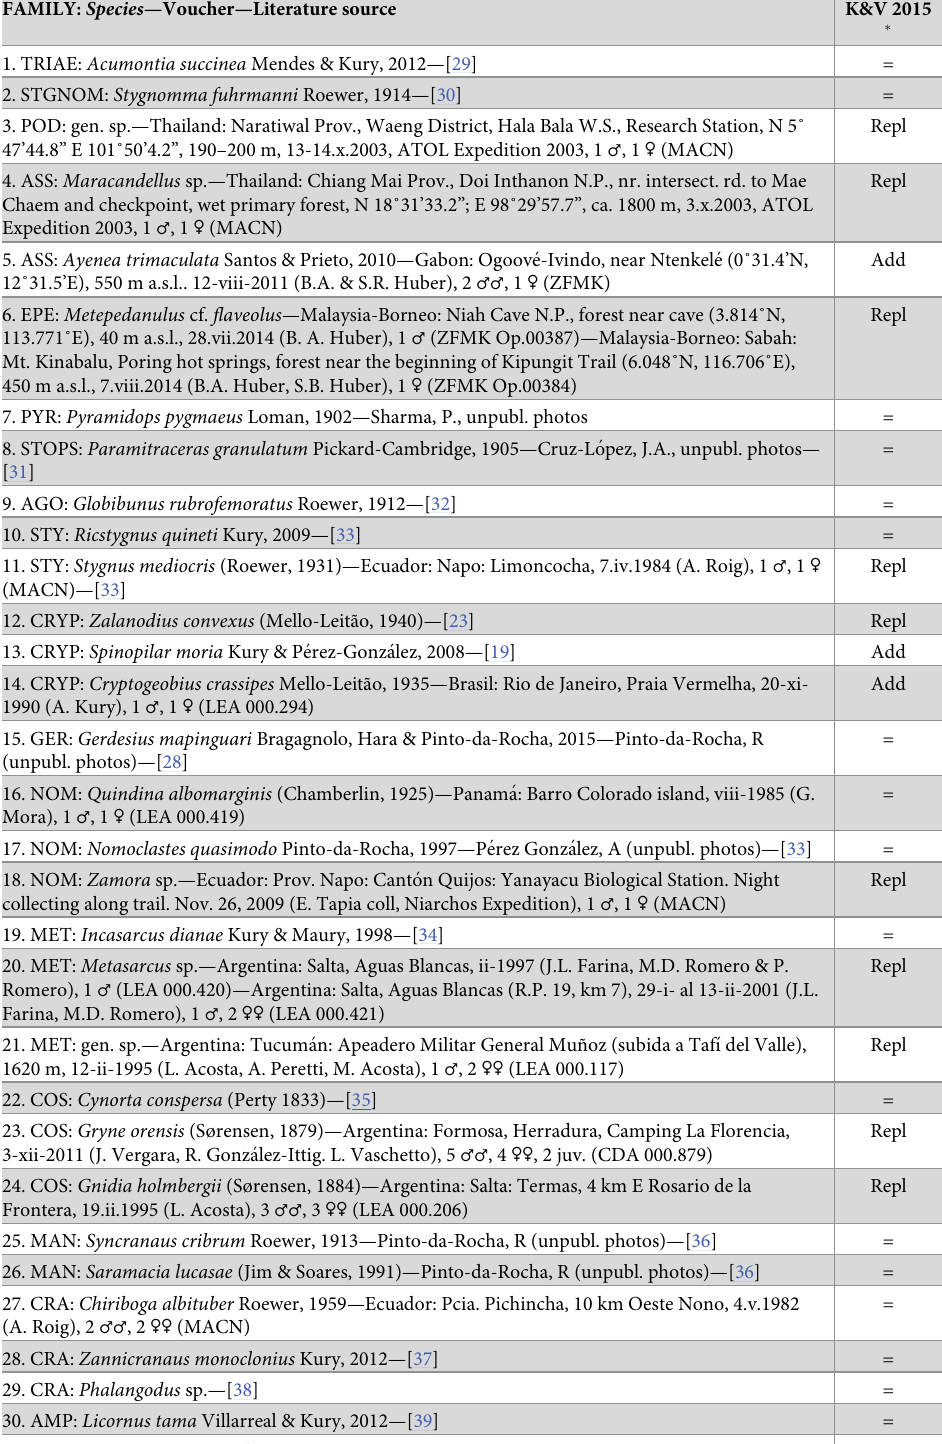
Table 1. List of terminals in the cladistic and Bayesian analyses, with literature sources or voucher specimens used to complete the scoring of taxa and characters. FAMILY: Species— Voucher—Literature